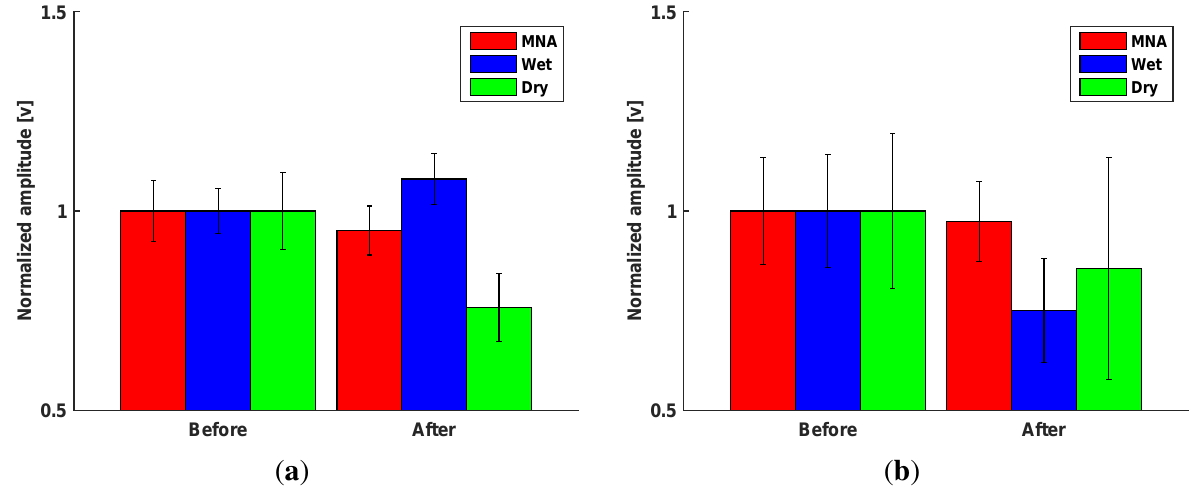
Figure 11. Performance evaluation of the proposed MNA electrode compared with the commercial electrodes in terms of insensitivity to perspiration before and after the exercise. Bars: ± 1 SD, n =